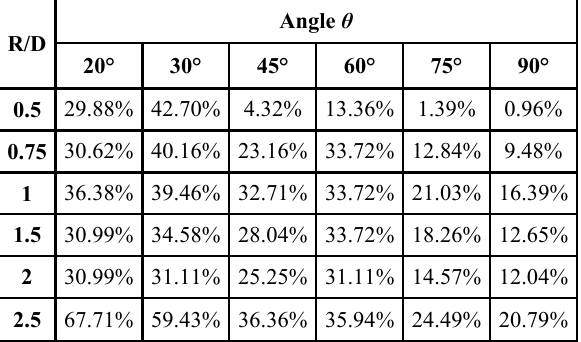
Table 2. Ratio of absolute value of standard deviation to the average value expressed in percent